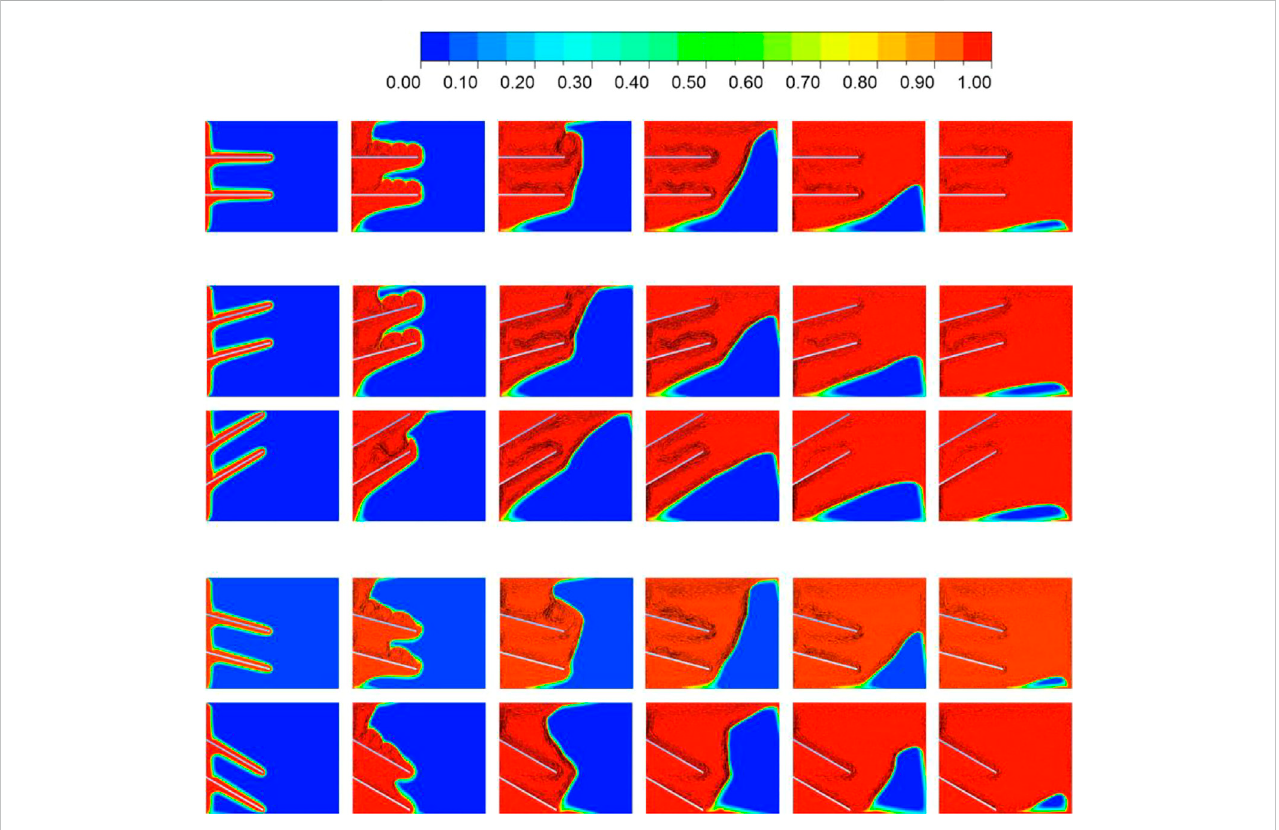
FIGURE 15 Contoursofthemeltfractionwithnaturalconvectiondriven fl owvectorsforthe fi n-PCMcases: (A) θ =0 ° ; (B) θ =15 ° ; (C) θ =30 ° ; (D) θ =15 ° and (E) θ =30 ° , with the fi xed dimensionless fi n length l/L = 0.50 and heat fl ux input q n = 2500 W/m 2 (Ji et al., 2018).